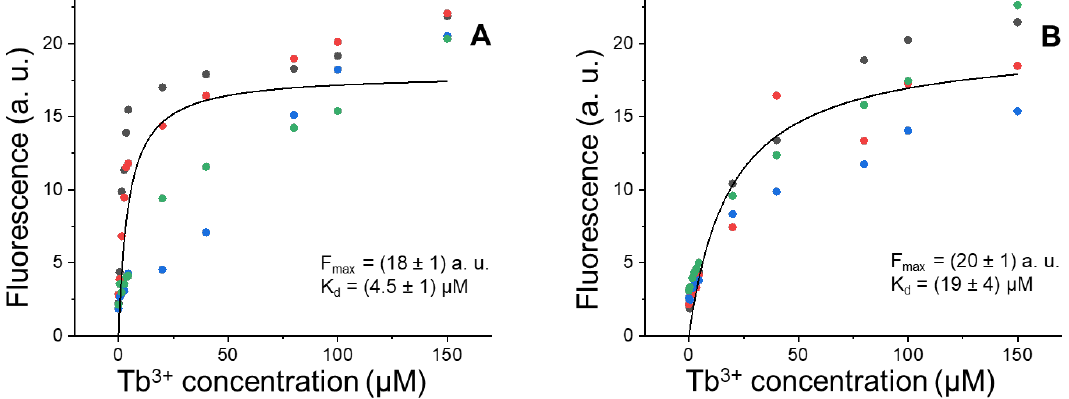
Figure 2. Lf-Tb 3+ binding properties. Tb 3+ titration of pooled tears samples after one week without CLs ( A ) and one week of CLs wearing ( B ). Fluorescence emission at 550 nm is reported. Data points of four experimental sets for each condition are indicated with distinct colors. Global fitting of the experimental sets with Equation (1) is shown as a black curve and the resulting fitting parameters are reported in each panel.